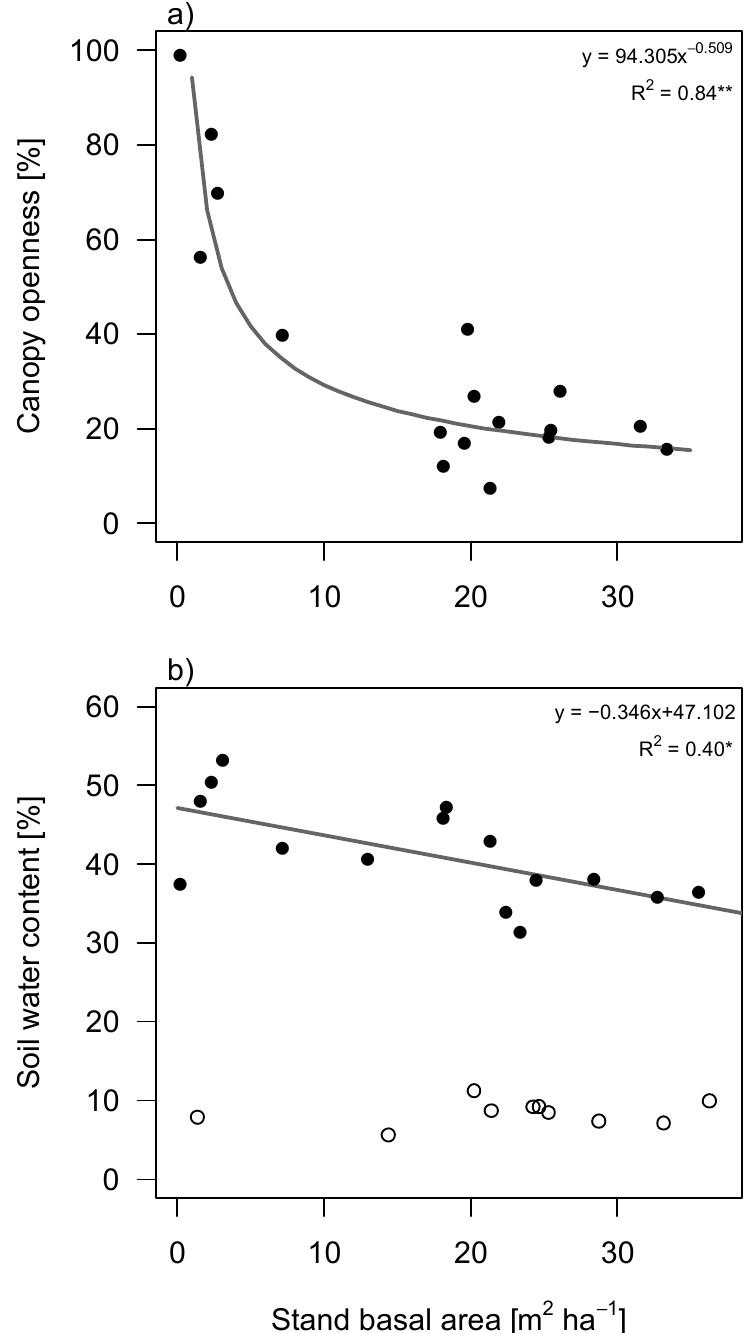
Figure 2. Changes in light and water availability during succession in tropical secondary forest in South-eastern Mexico. ( a ) Changes in canopy openness as a function of stand basal area; ( b ) Changes in soil water content as function of stand basal area. Filled circles correspond to measurements in the wet season (2013) and open circles to measurements in the dry season (2009). Regression lines are given if significant. Best fitting curves are depicted (tested for linear, exponential and logarithmic) with R 2 value. * = p < 0.05, ** = p < 0.01. Plots showing the relationship between canopy openness and soil water content with stand age can be found in supplementary materials (Figure